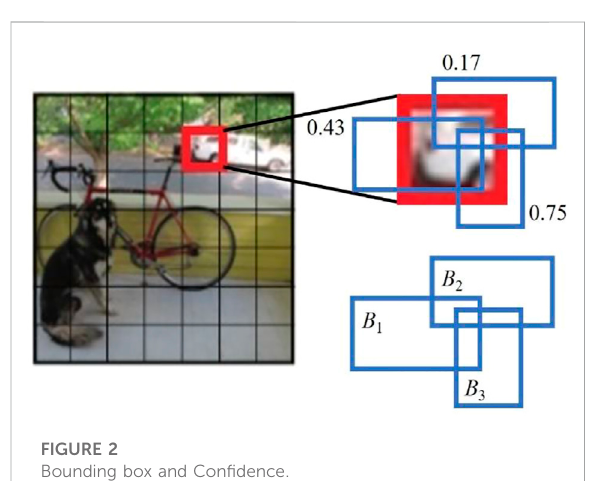
FIGURE 2 Bounding box and Con fi dence. FIGURE 3